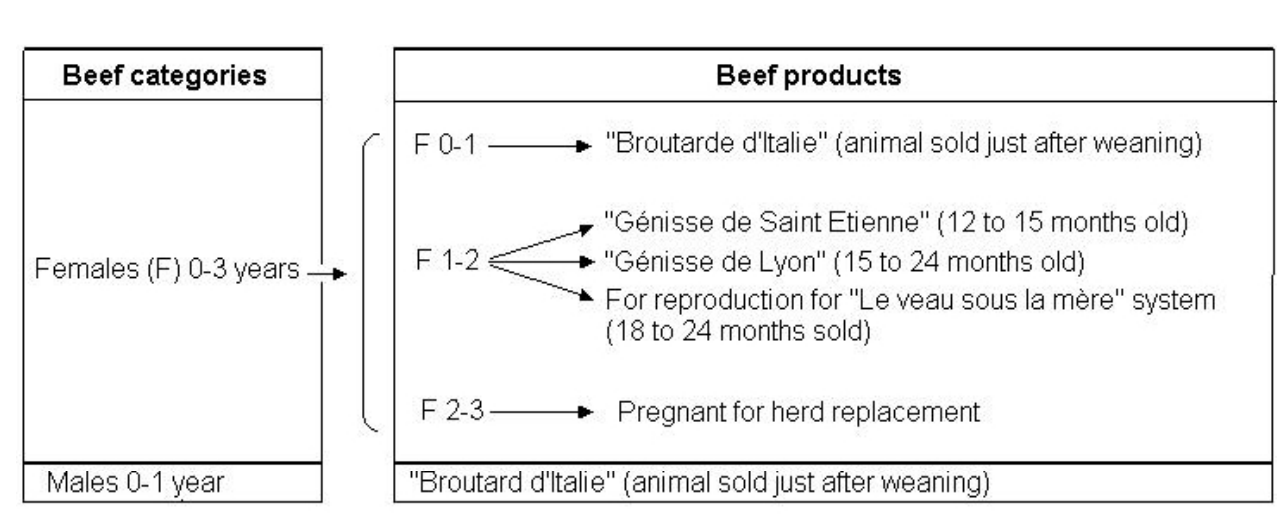
Fig. 3. Product mix of the Limousin beef